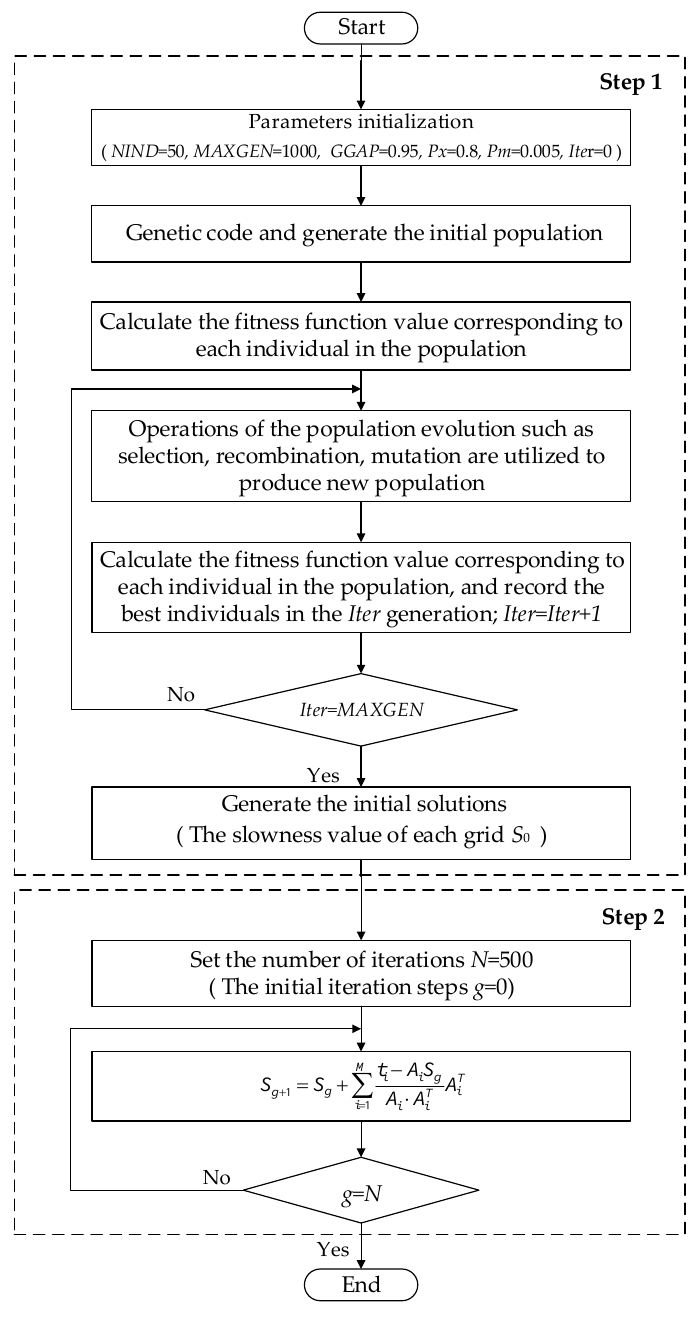
Figure 1. Flow chart of the hybrid algorithm.